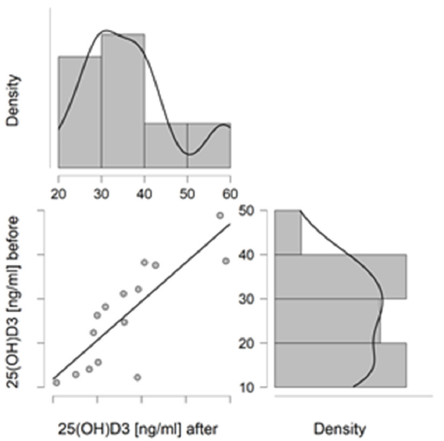
Figure 3. Correlation plot for 25(OH)D 3 concentrations in patients from the NW group at baseline (before) and after 6 weeks of training (after).